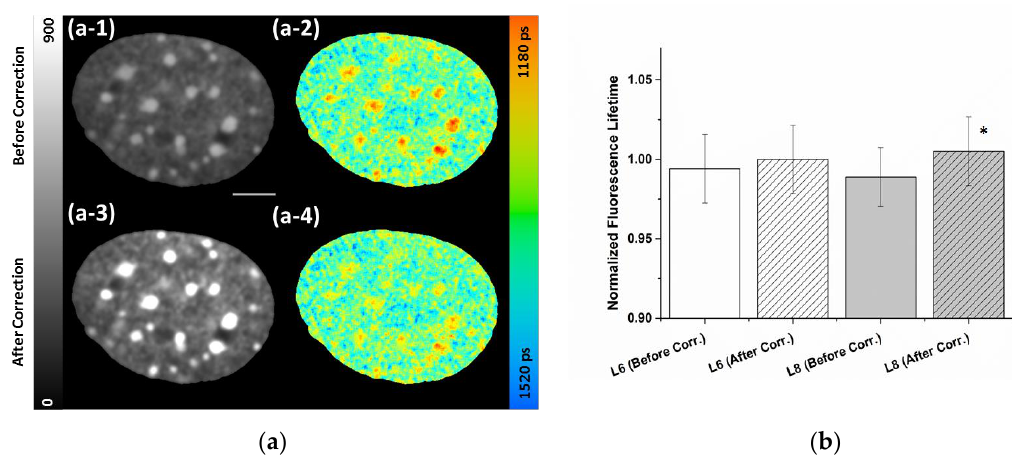
Figure 2. Influence of the pixel-wise correction of detector dead-time and pile-up. Confocal FLIM images of NIH/3T3 cell nucleus stained with Hoechst 34580 recorded at an average count rate of 0.9 MHz an 80 MHz laser repetition rate. ( a ) (a-1) uncorrected intensity image and (a-2) uncorrected lifetime image. (a-3) Intensity image with counting loss correction showing improved contrast and (a-4) lifetime image with the pile-up correction leading to increased values especially at high intensity areas. LUT at left side indicates photon counts for uncorrected (a-1) and corrected (a-3) intensities on same scale (0 – 900). The fluorescence lifetime is shown in a continuous pseudo-color scale (right) ranging from 1180 to 1520 ps. Scale bar, 5 µm. ( b ) Quantification of pile-up correction for different laser settings (L6: 2.7 or L8: 10 µW). Lifetime values were normalized to the corrected values of low laser intensities (2.7 µW). Asterisk represents (*) p < 0.05 (using Student’s t -test) compared to the uncorrected values of higher laser intensities. Error bars indicate mean ± SD; n = 15.